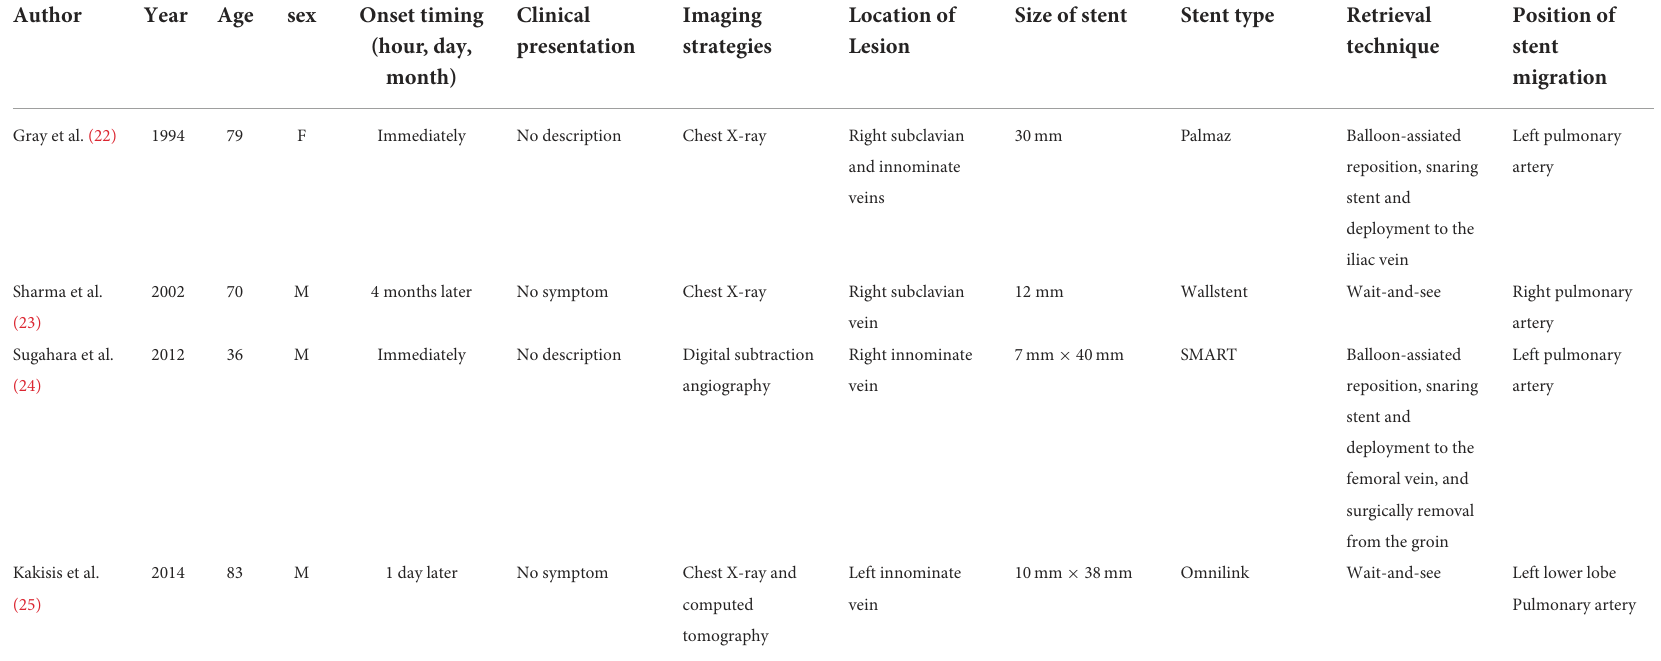
TABLE 2 Clinical and technical aspects of four patients with misplaced or dislodged stents in the pulmonary artery.